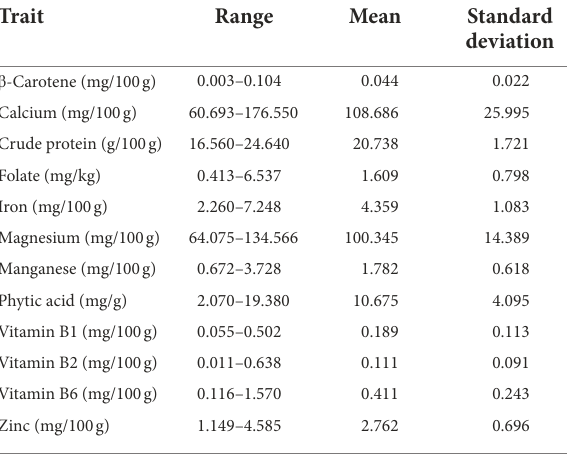
TABLE 1 Descriptive statistics for the key nutritional traits in the chickpea reference